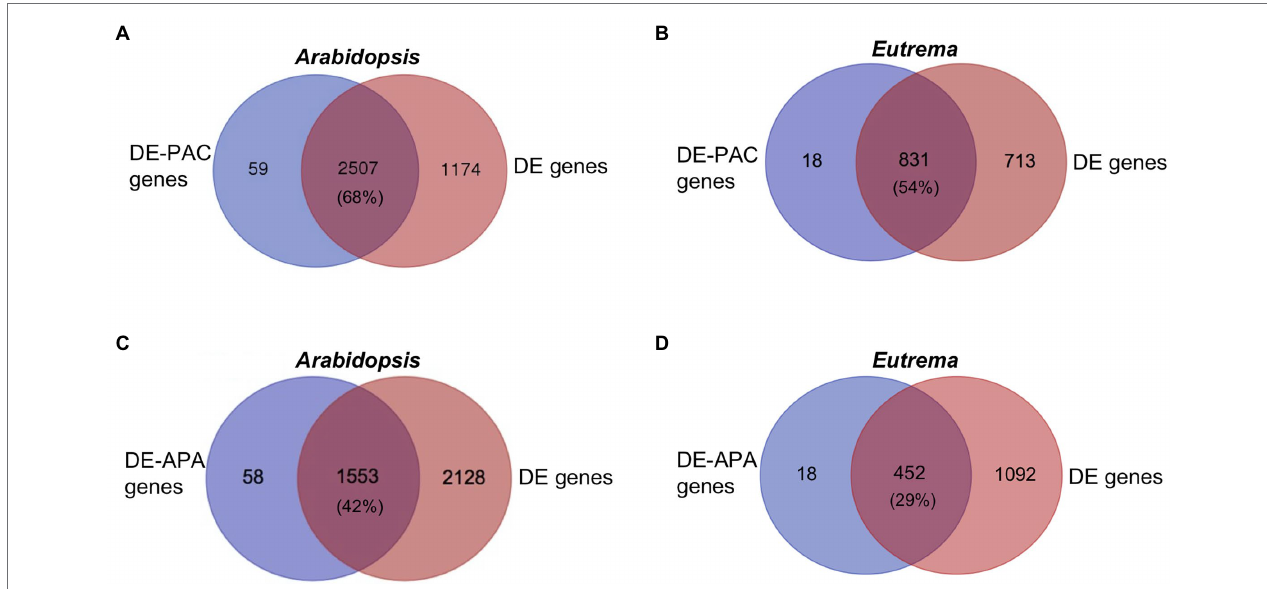
FIGURE 4 | Venn diagrams for DE-PAC genes, differentially expressed APA genes (DE-APA genes), and differentially expressed genes (DE genes). (A,B) The overlap of DE-PAC genes and DE genes under salt stress in Arabidopsis and Eutrema . Numbers indicate gene numbers. Percentages indicate the fraction of DE genes overlapping with DE-PAC genes. (C,D) The overlap of DE-APA genes and DE genes under salt stress in Arabidopsis and Eutrema . Percentages indicate the fraction of DE genes overlapping with DE-APA